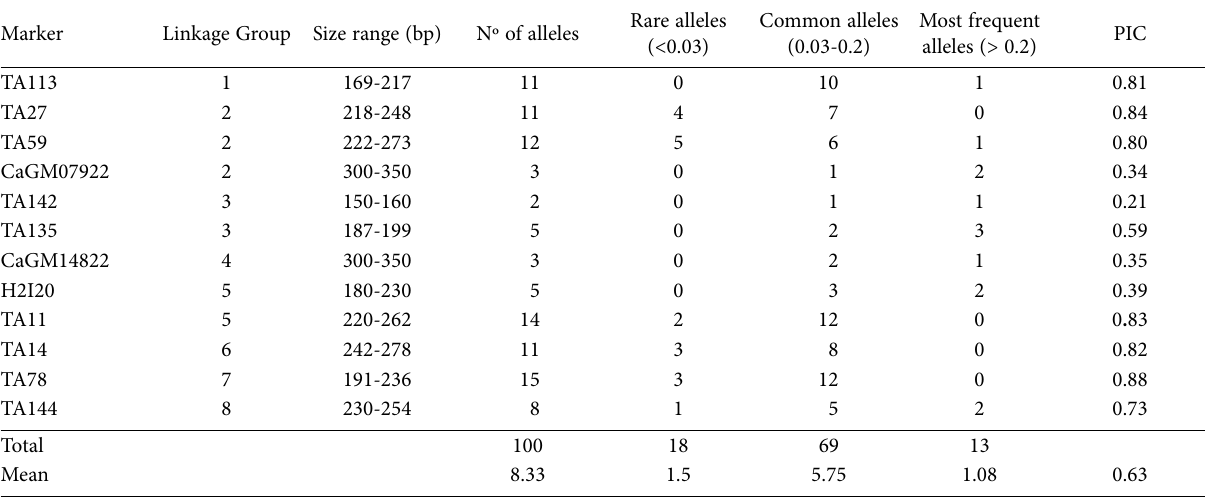
Table 2. Size ranges, numbers and frequencies of alleles and Polymorphism Information Content (PIC) observed in 18 Italian chickpea lan- draces, studied with 12 microsatellite markers.